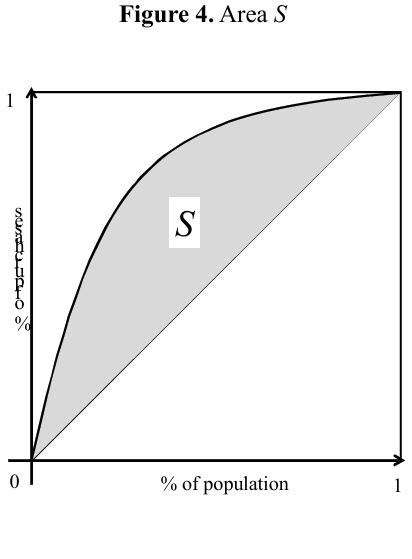
Table 3. Comparison of HB Model and